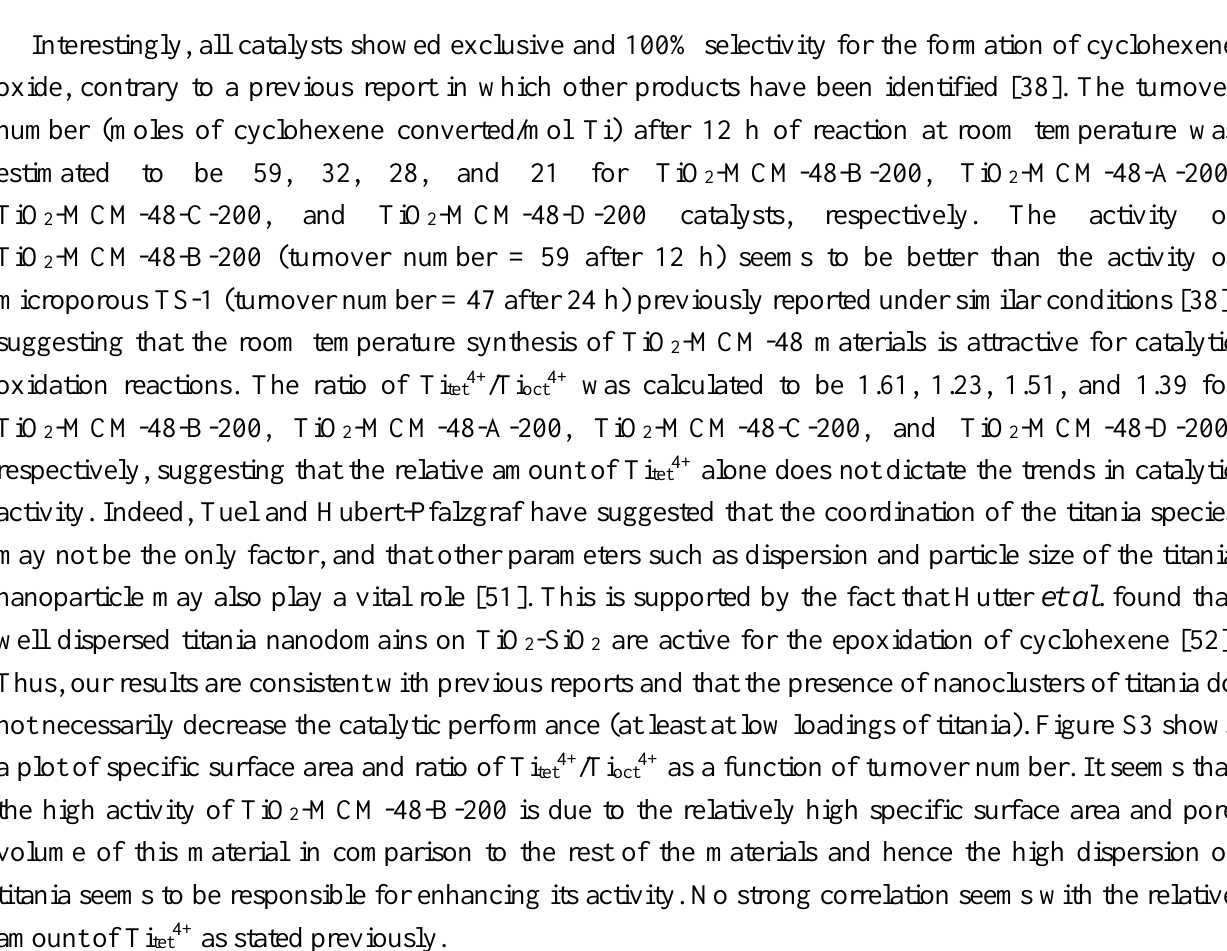
Figure 8. Conversion of cyclohexene over various TiO 2 -MCM-48-200